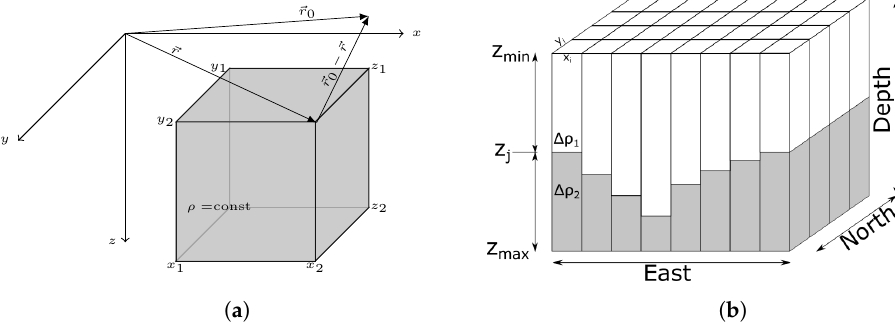
Figure 2. ( a ) Single prism of constant density in Cartesian coordinates for gravity measurements and ( b ) an example of n x × n y × 2 = 64 juxtapositioned prisms for depth